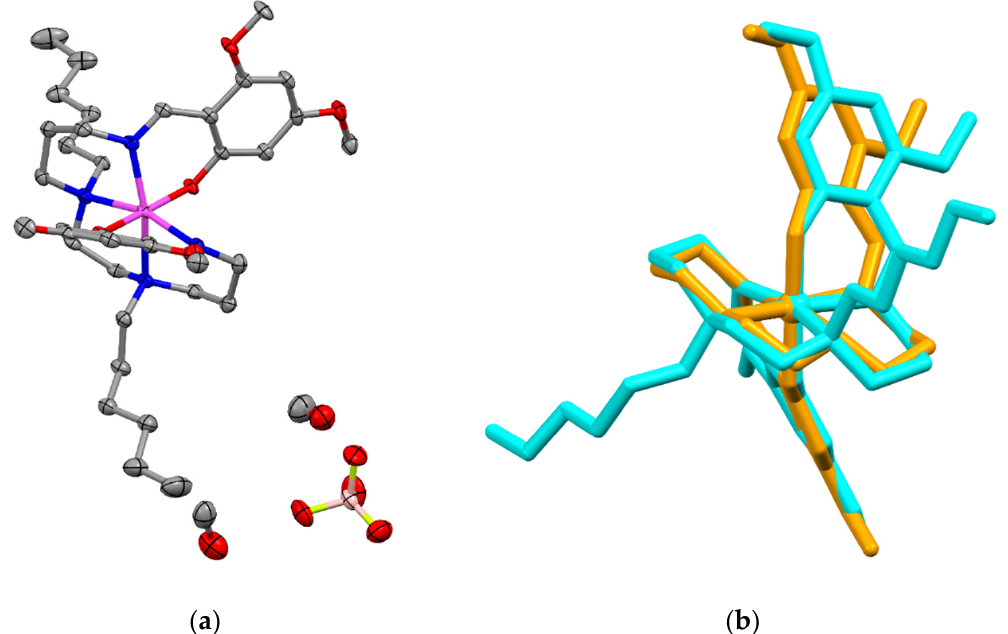
Figure 6. Asymmetric unit of complex ( 6 ), [Mn(4,6-diOMe-sal 2 323-C 6 )](BF 4 ) 0.8 (ClO 4 ) 0.2 ·2CH 3 OH ( a ); and the structural overlap of the cationic species, [Mn(4,6-diOMe-sal 2 323)] + , of complex ( 1 ) [Mn(4,6- diOMe-sal 2 323)]ClO 4 ·0.5H 2 O, (orange), and complex ( 6 ) [Mn(4,6-diOMe-sal 2 323- C 6 )](BF 4 ) 0.8 (ClO 4 ) 0.2 ·2CH 3 OH (turquoise) ( b ). Data collected at 100 K, interstitial solvent molecules, minor anionic component and hydrogen atoms omitted for clarity.